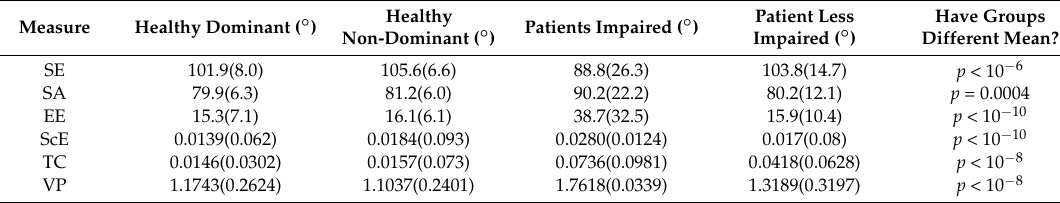
Table 4. Summary of the results of the biomechanical